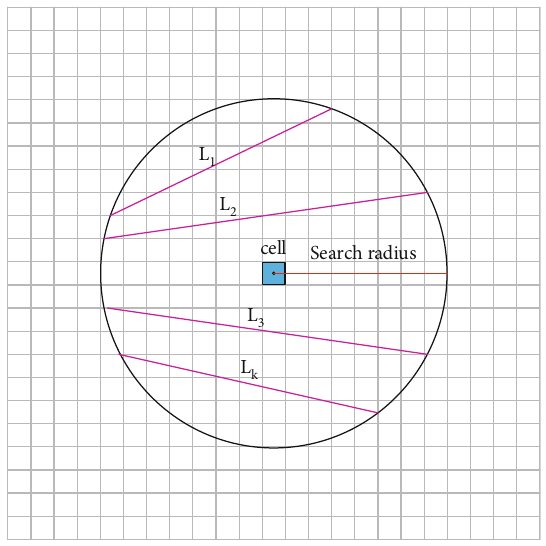
Figure 13: Schematic diagram of line density analysis